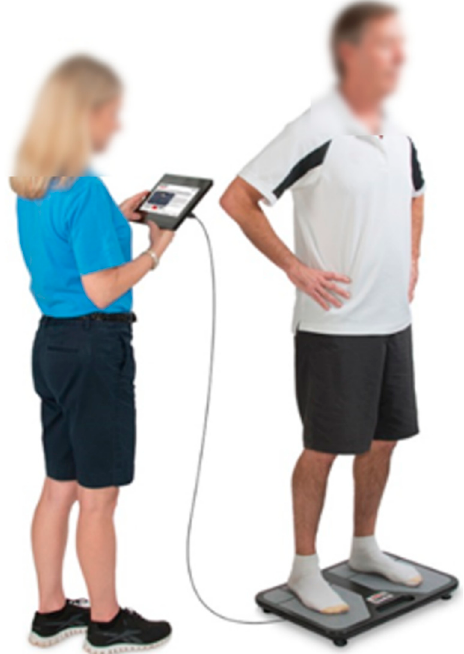
Figure 1. BTracks testing setup for a fall risk assessment.